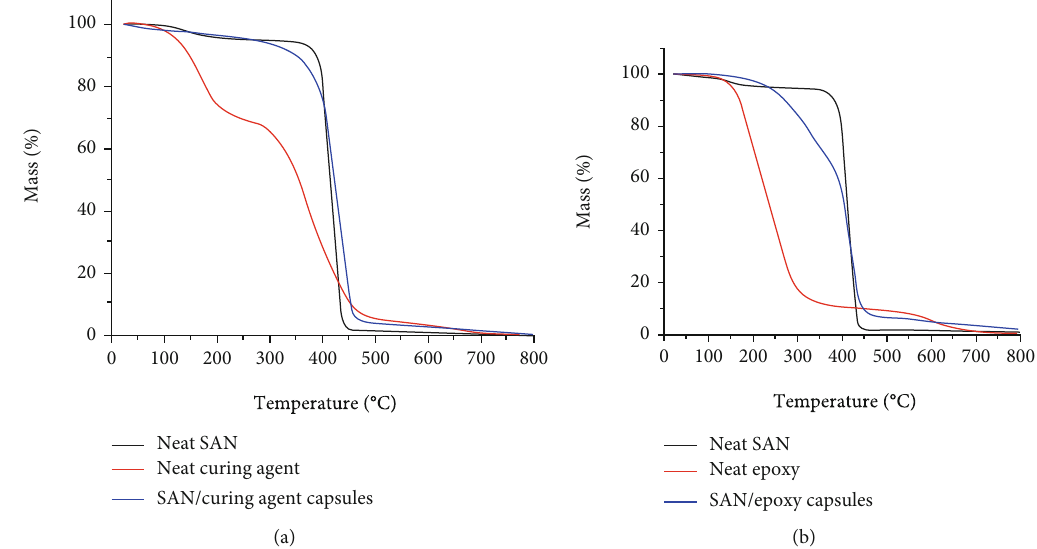
Figure 6: TGA thermograms of (a) neat SAN, neat epoxy resin, and epoxy-containing MCs (b) neat SAN, neat amine, and amine- containing MCs.